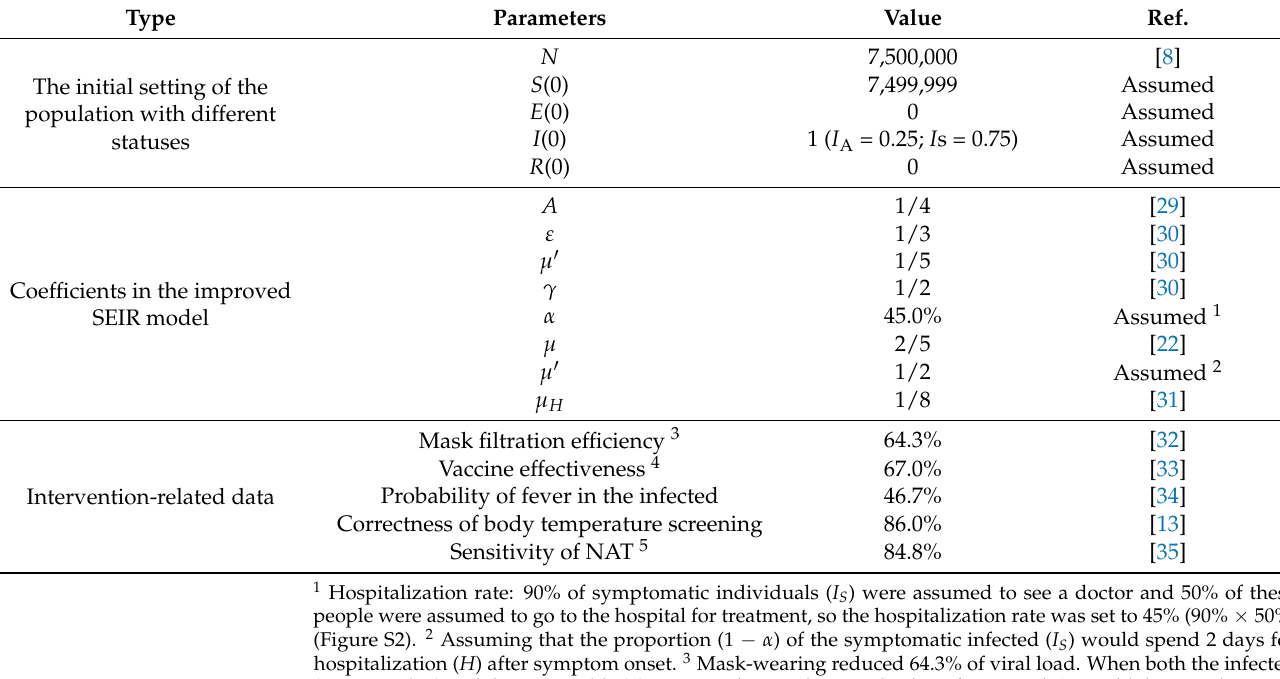
Table 2. Simulation-related parameters of the improved SEIR model.